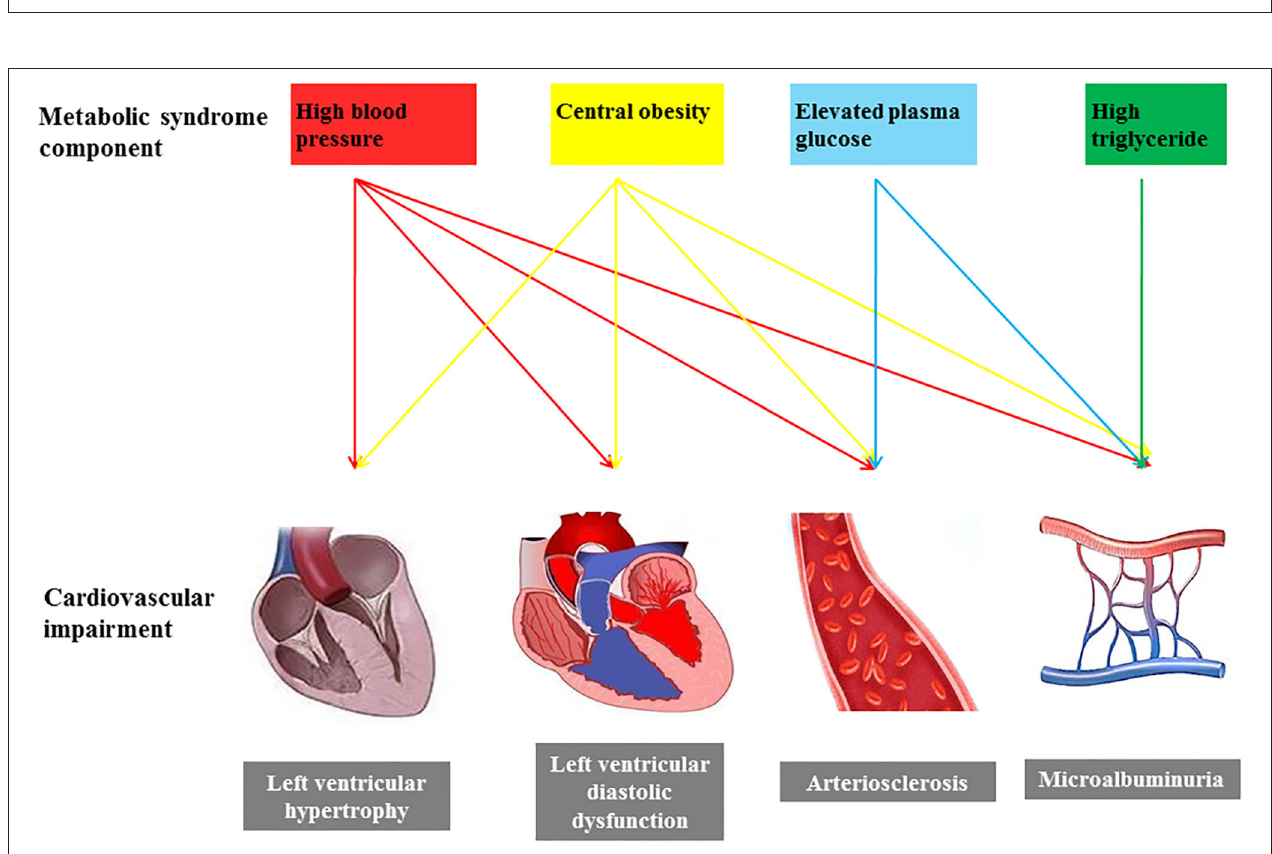
FIGURE 3 | The possible effect of individual components of metabolic syndrome on asymptomatic cardiovascular impairments.